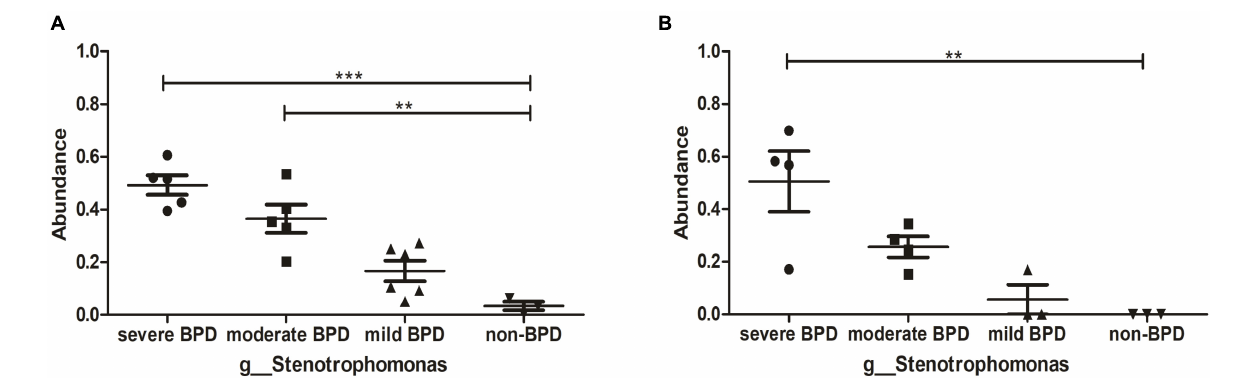
FIGURE 2 | Abundance of Stenotrophomonas . (A) The abundance of Stenotrophomonas at birth (Day 1); (B) The abundance of Stenotrophomonas on Day 7 after birth. *** P < 0.001; ** P < 0.01. On day 1, the number of infants with severe BPD, moderate BPD, mild BPD, and non-BPD was 5, 5, 6, and 3, respectively. On day 7, the number of infants was 4, 4, 3, and 3,